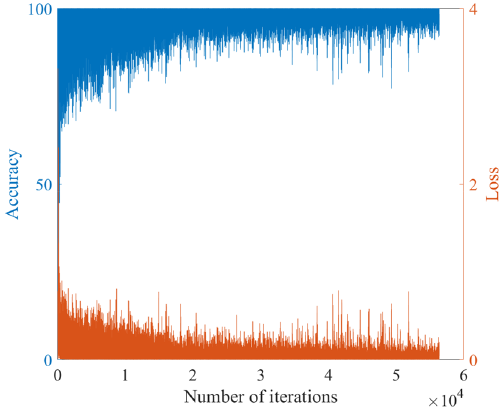
Figure 11. The training-process of the multi-step ahead thermal warning